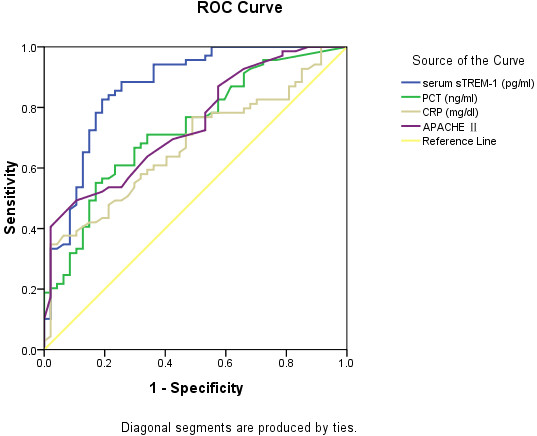
ROC curves for sepsis versus SIRS. Shown are the ROC curves for sTREM-1, CRP, and PCT levels and APACHE II score for distinguishing sepsis from SIRS